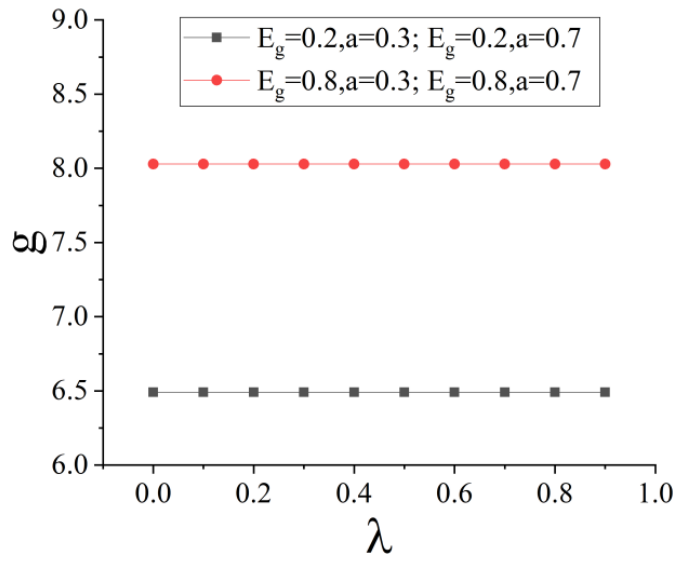
Figure 5. The impact of fairness concerns manufacturers on the product green degree.